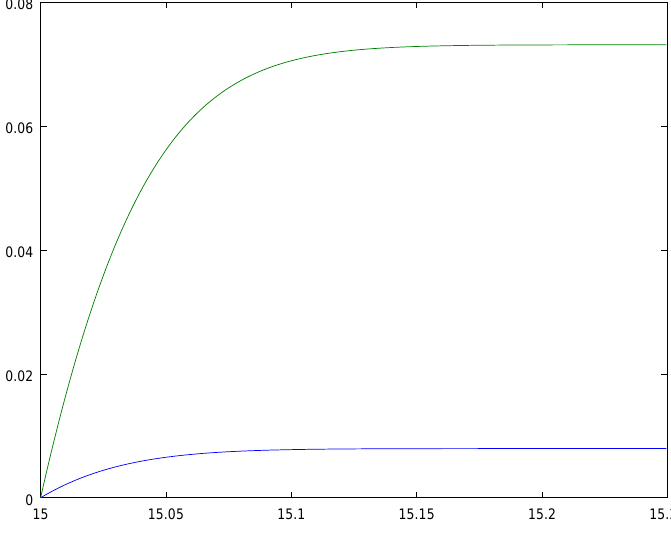
( t ) (blue). 0 (cid:48)